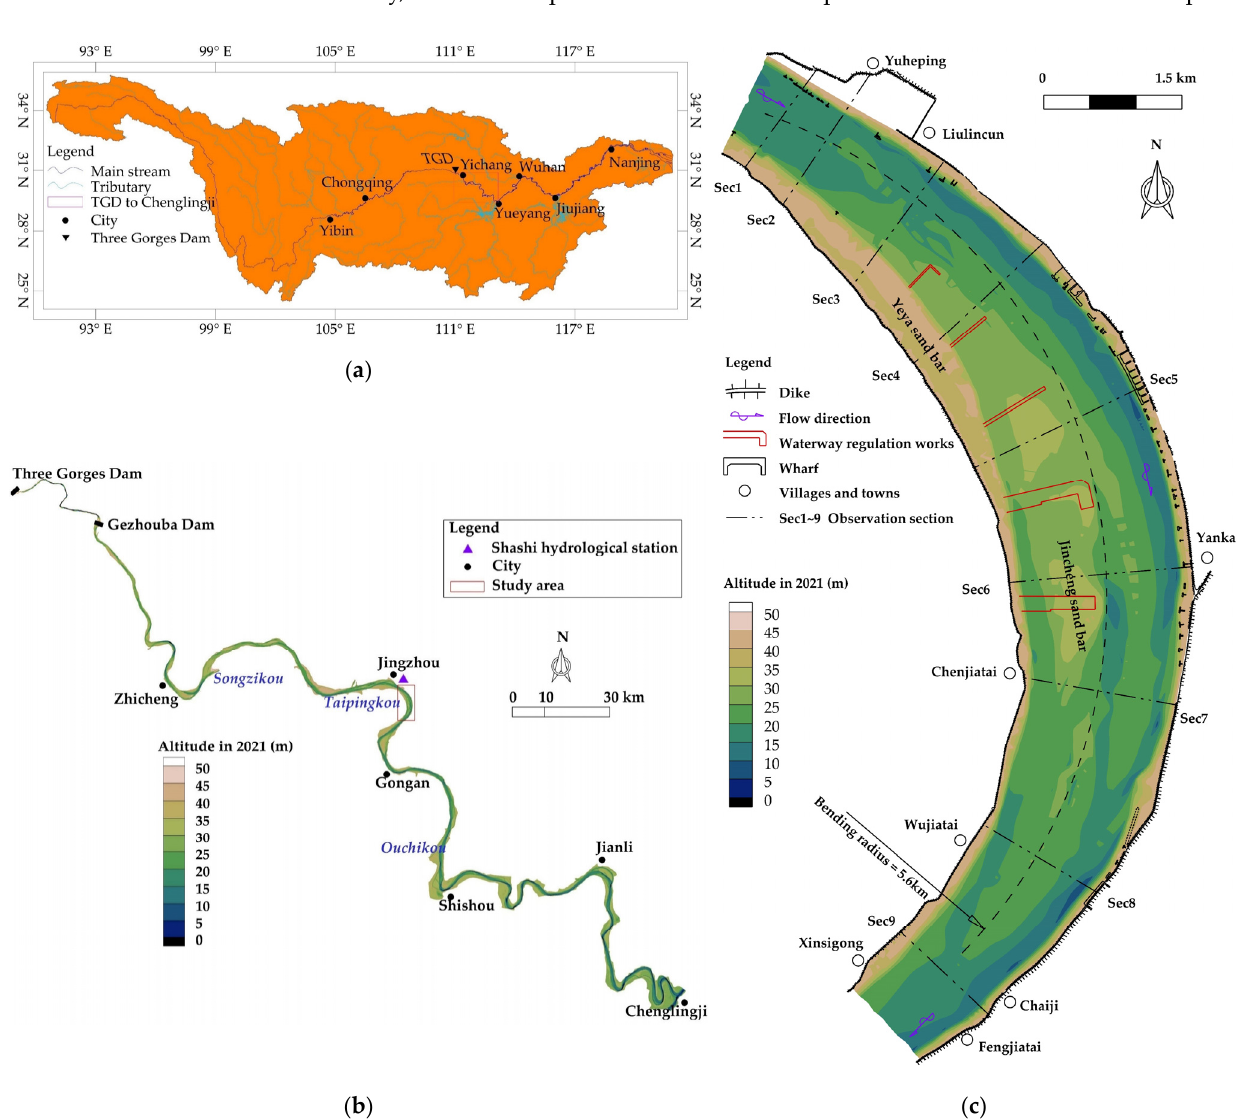
Figure 1. The geographical location of Wakouzi waterway and its river regime. ( a ) Yangtze River Basin; ( b ) Jingjiang reach; ( c ) River regime of Wakouzi waterway.